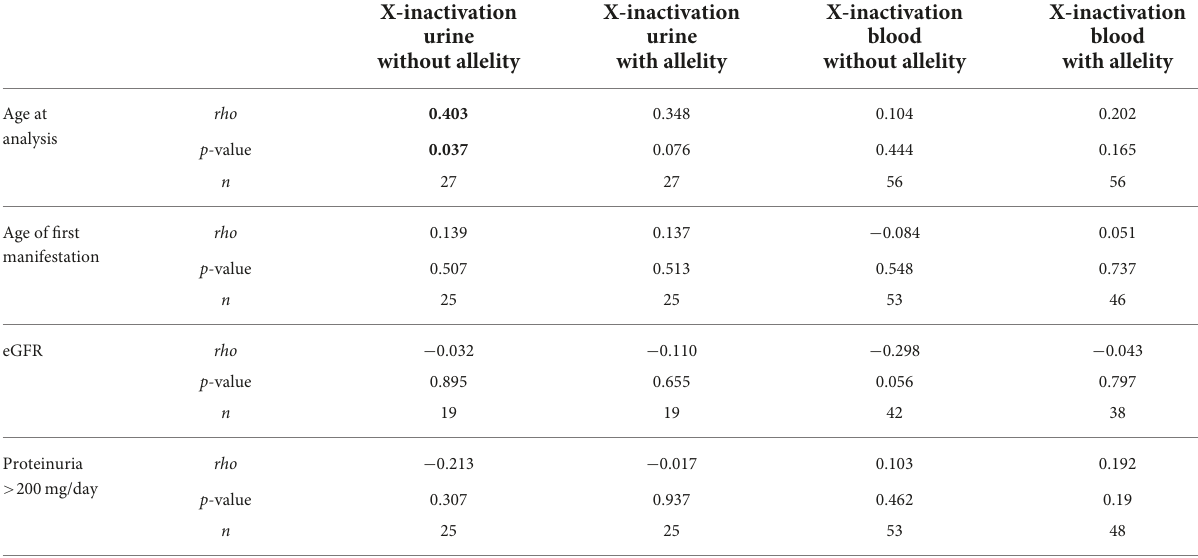
TABLE 1 Correlation coefficients of X-inactivation in blood and urine with phenotypic markers in female individuals with a heterozygous variant in